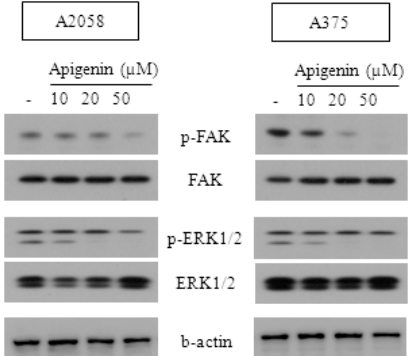
Figure 3. Effect of apigenin on ERK- and FAK-dependent mechanisms. A375 and A2058 melanoma cells were treated with the indicated concentrations of apigenin for 24 h. p-FAK, FAK, p-ERK 1/2 and ERK 1/2 expressions were measured by western blotting analyses. All data are representative of three separate